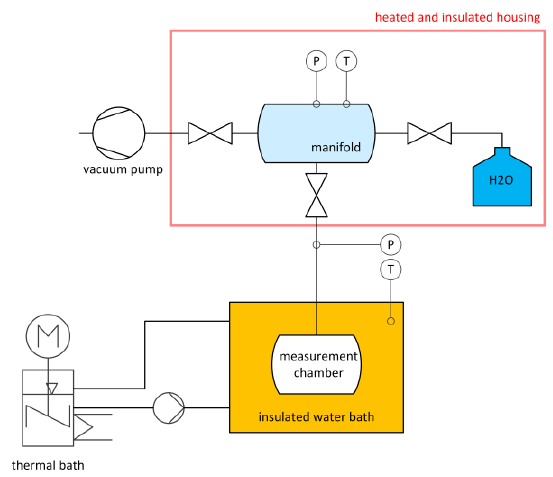
Figure 5. Schematic of Quantachrome Autosorb iQ surface area analyzer, based on volumetric sorp- tion measurement.